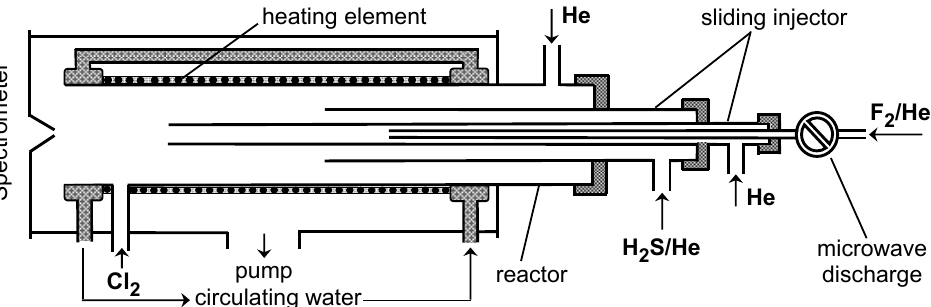
Figure 1. High-temperature flow reactor: configuration used in the measurements of the rate coefficient of reaction (1).